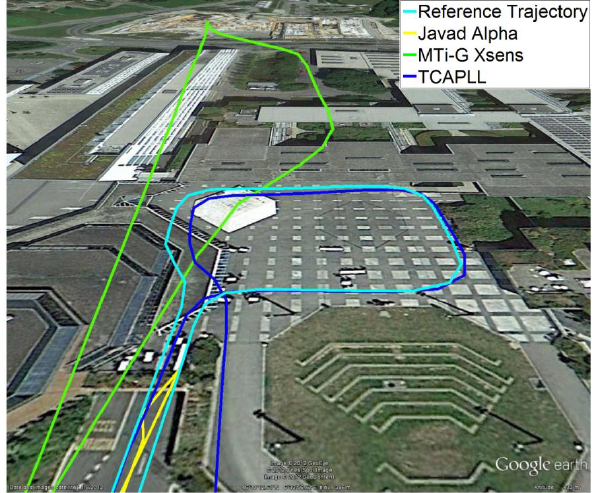
Figure 28. Position solution during the 30 s trajectory in the underground parking structure.